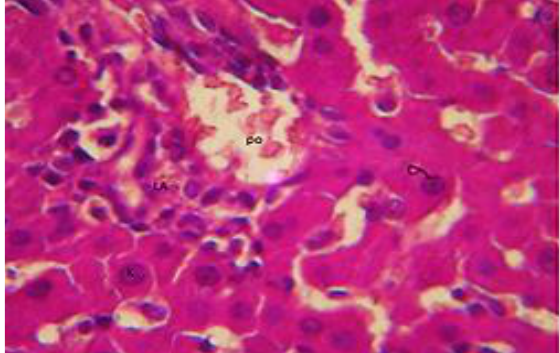
Figure, 3: Photomicrograph of a section of the liver of rats T2 group, Lymphoid aggregation around portal area and increase in kupffer cells, Po= portal area, LA=lymphoid aggregation, K= kupffer cell. X40, EandH